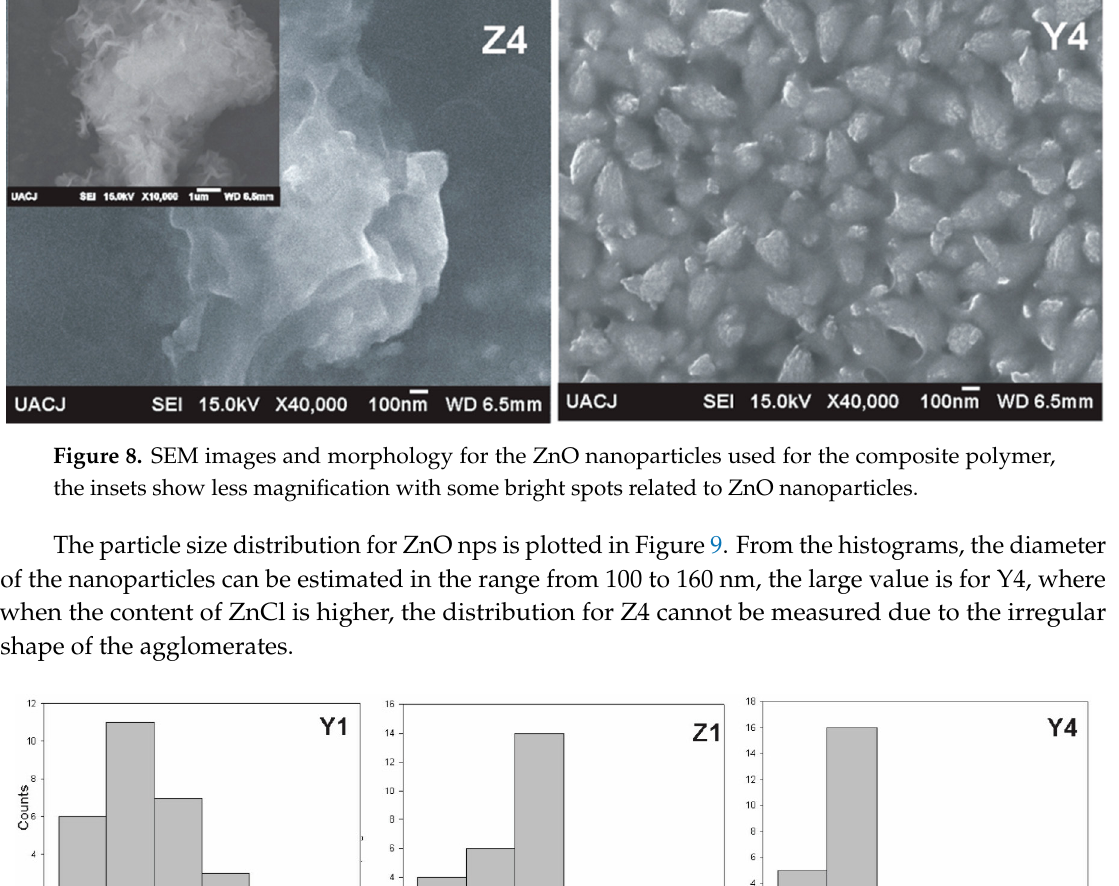
Figure 9. Size distribution for the ZnO prepared under different conditions.